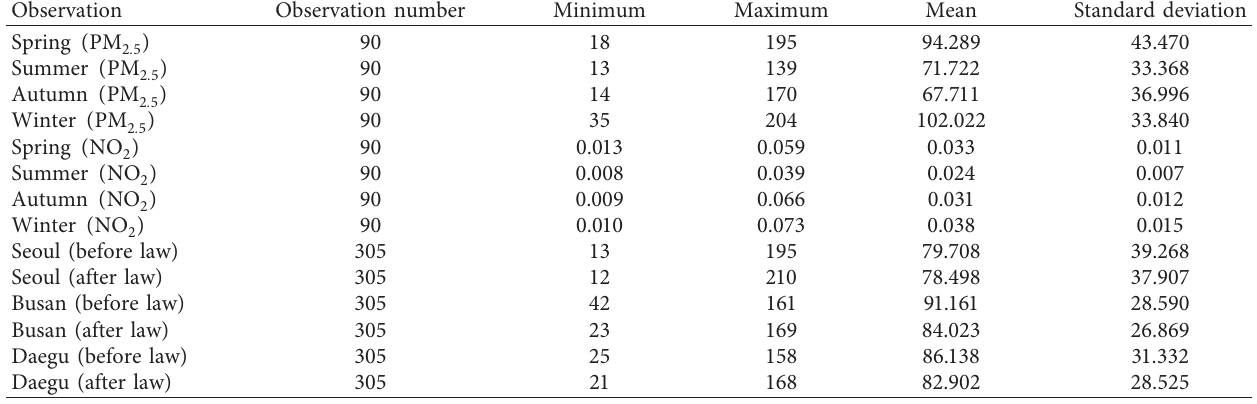
Table 2: Descriptive statistics.